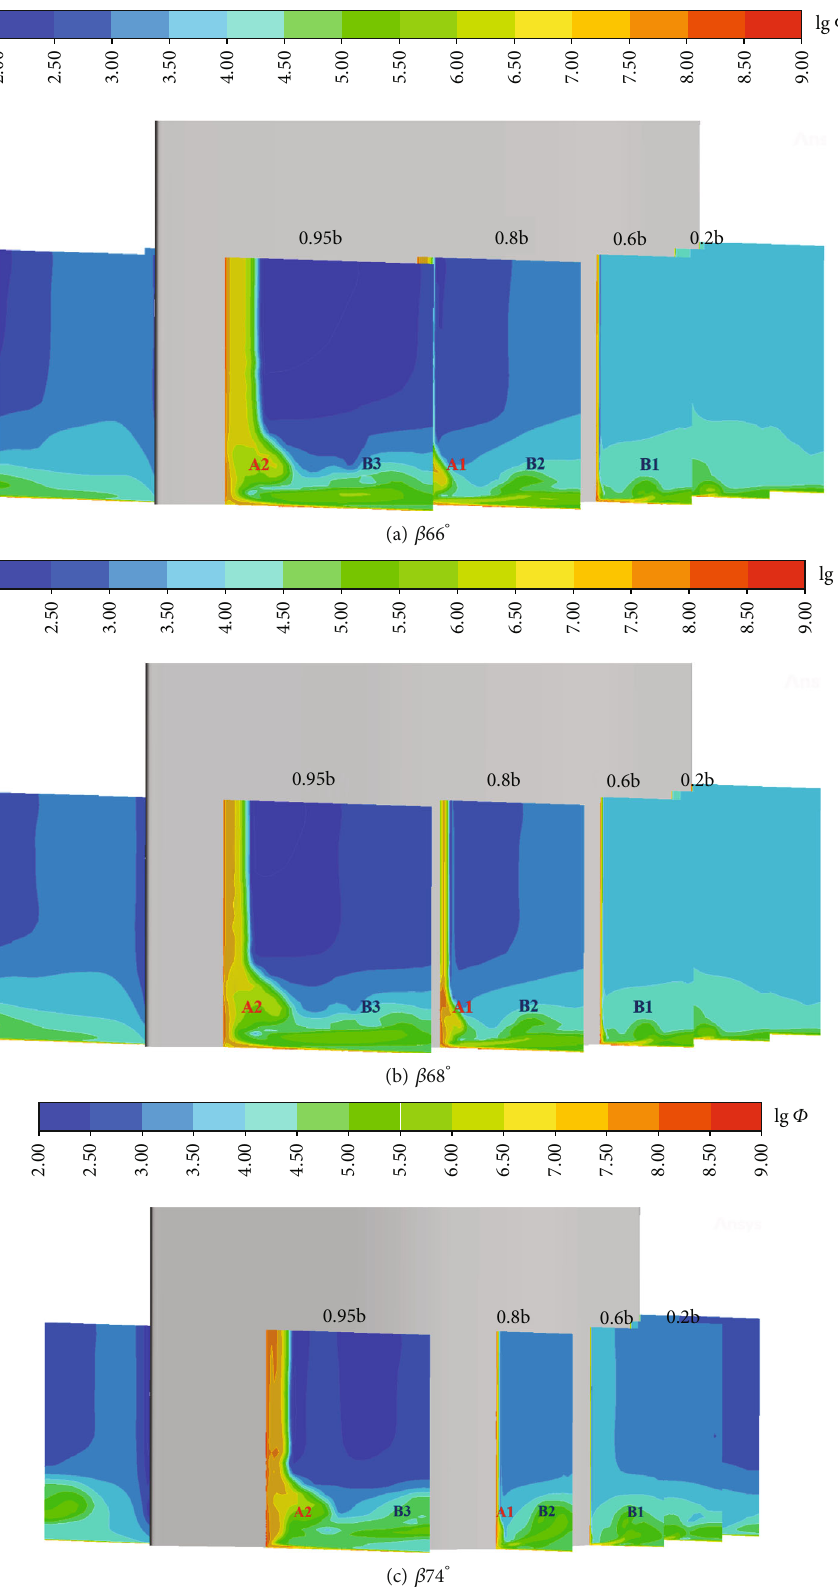
Figure 16: Comparison of dissipation functions for di ff erent exit